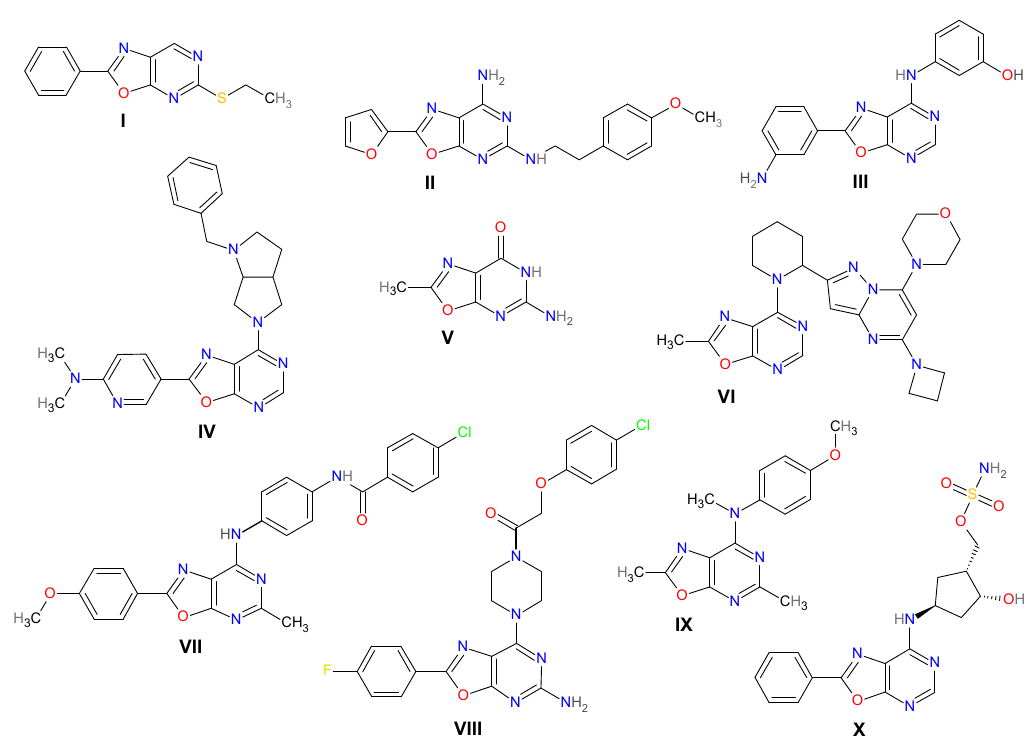
Figure 1. Selected oxazolo[5,4- d ]pyrimidines showing biological activity.